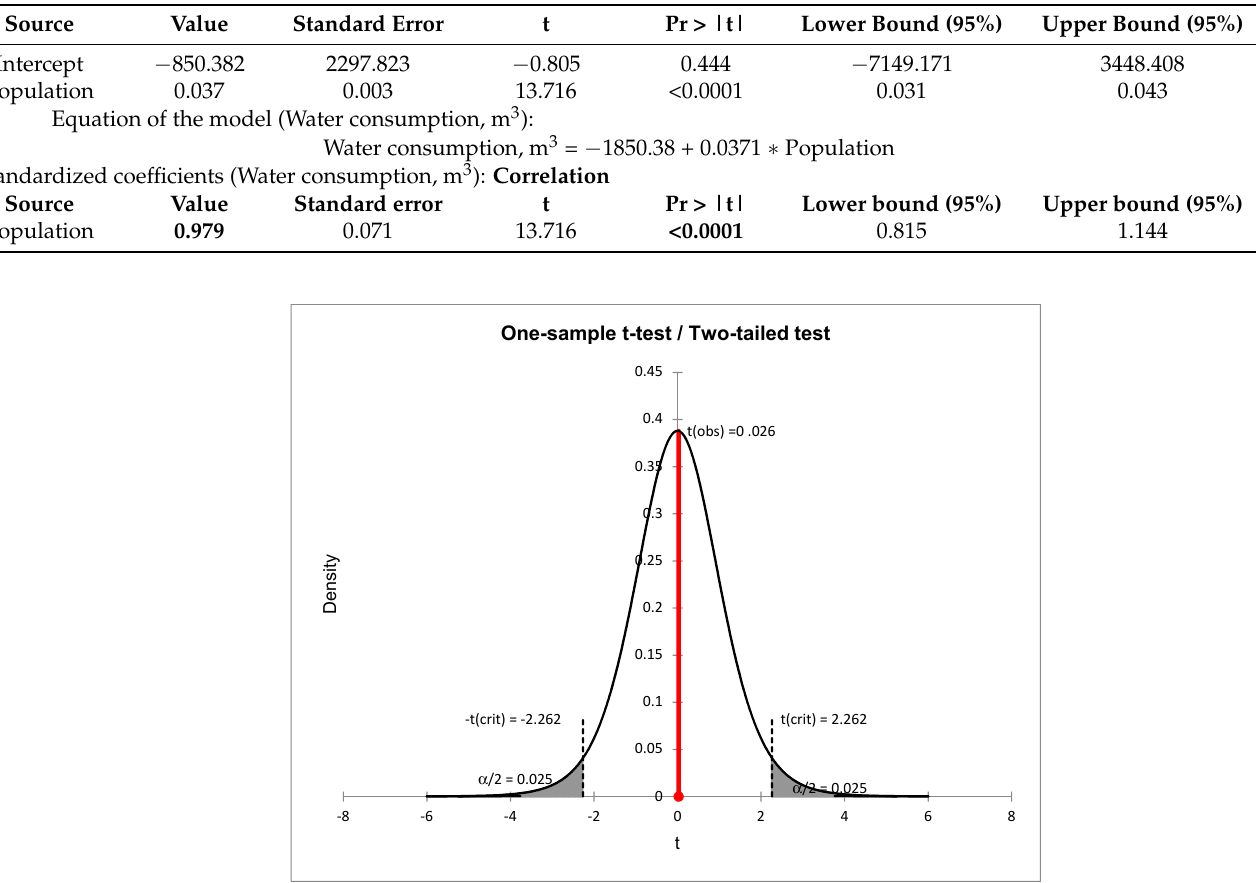
Figure 2. One-sample t -test/Two-tailed test for water consumption during COVID-19.